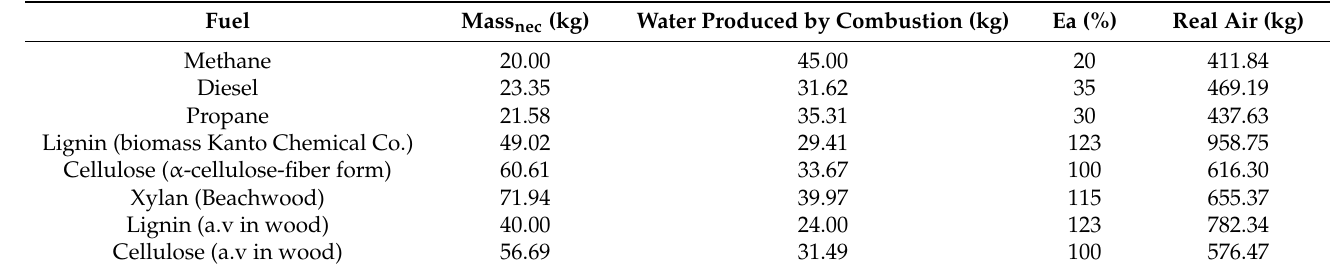
Table 5. Mass of fuel required to produce 1000